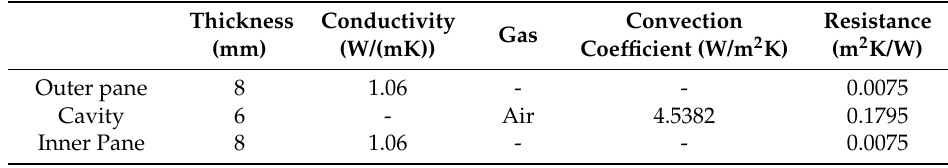
Table 4. Details of RC external window design in Beijing